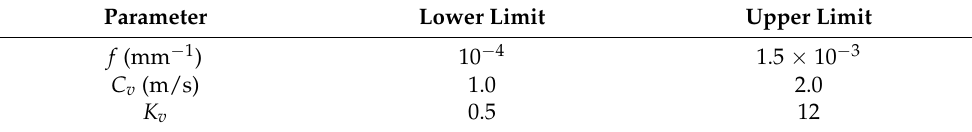
Table 5. Ranges of the RIBS model parameter values used in the calibration